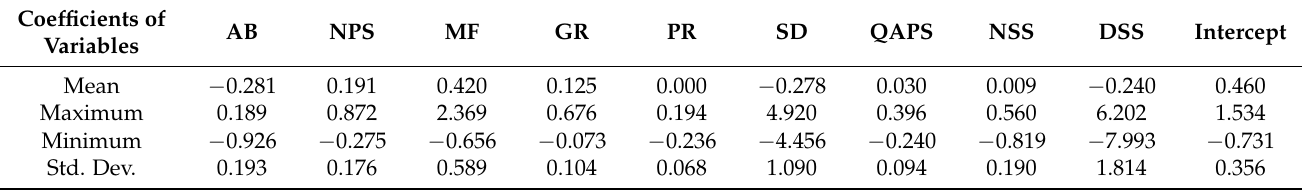
Table A6. Descriptive Statistics of Coefficients of Variable from